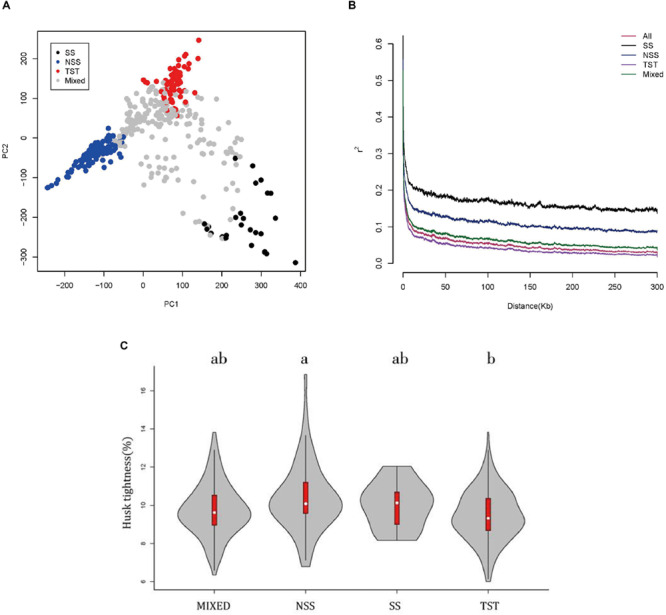
The PCA, linkage disequilibrium and boxplot of maize husk tightness (HTI) distributions in subgroups. (A) PCA plot for 508 maize inbred lines. SS green, NSS blue, TST red, Mixed pink. (B) Linkage disequilibrium among the entire panel (508lines), SS, NSS, TST, and Mixed subgroups. (C) Boxplot of maize husk tightness (HTI) distributions in subgroups. An analysis of variance was used to examine the differences in traits among subgroups. The numbers of inbred lines included in each subpopulation are 215, 70, 27, and 196 for Mixed, NSS, SS and TST, respectively.